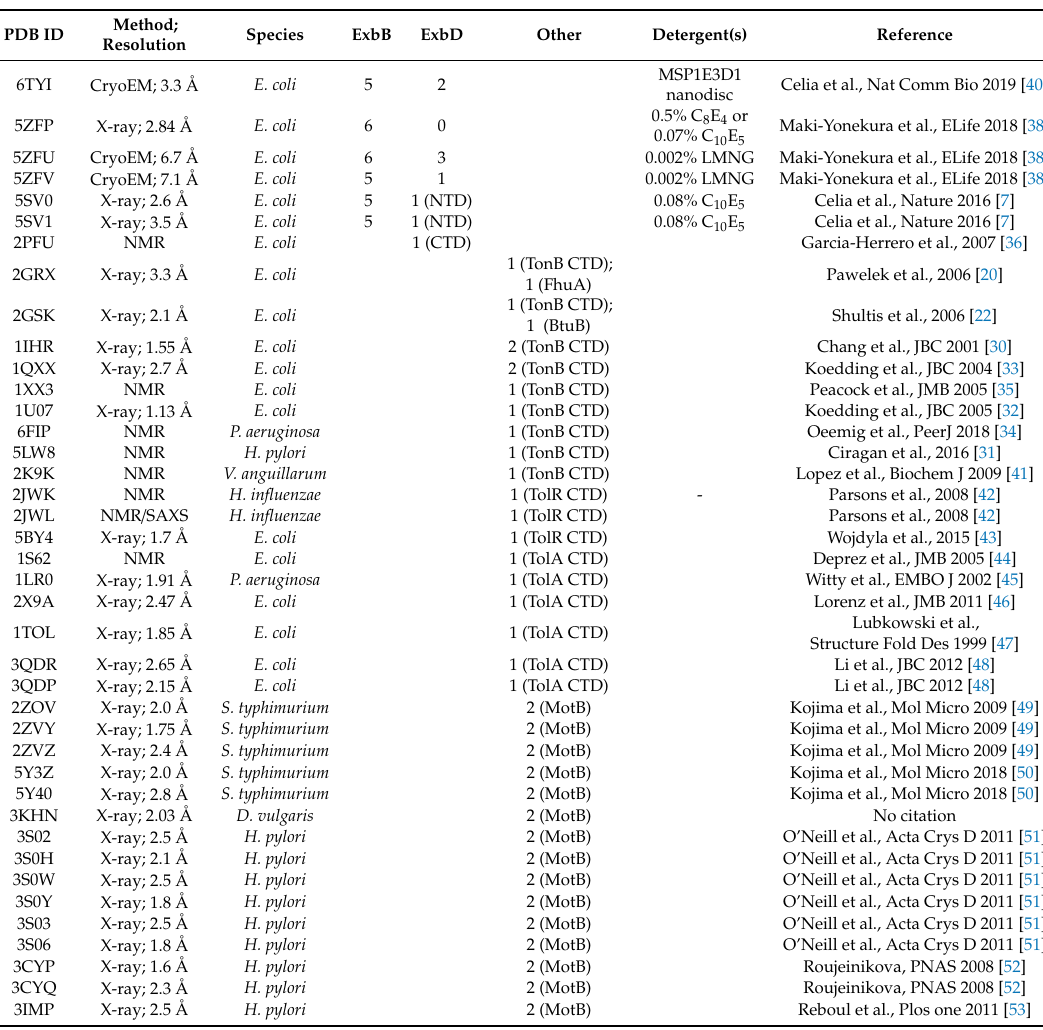
Table 1. Summary of Ton-related